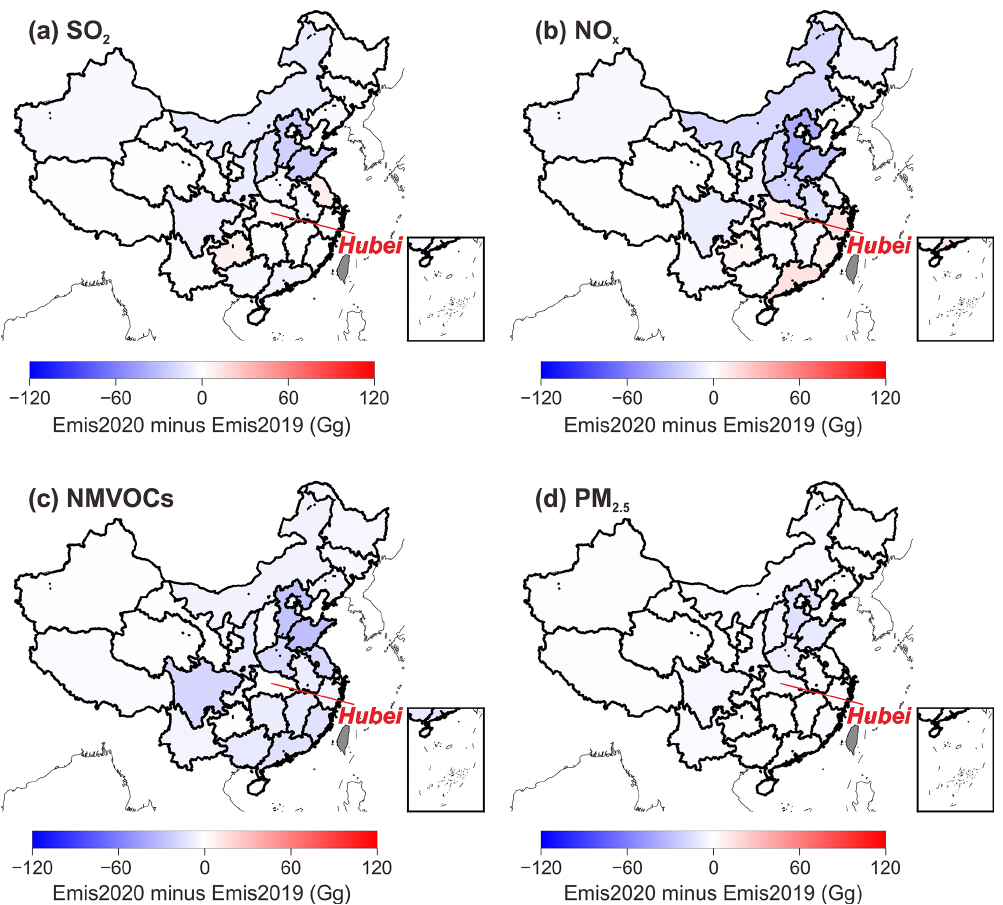
Figure 4. Differences in May–August emissions between 2019 and 2020. Four pollutants are presented including SO 2 (a) , NO x (b) , NMVOCs (c) , and PM 2 . 5 (d) . The background map shows the provincial borders in China. The color of each province represents the emissions from May to August in 2020 minus the emissions from May to August in 2019. The grey color represents the province whose data are not estimated in this